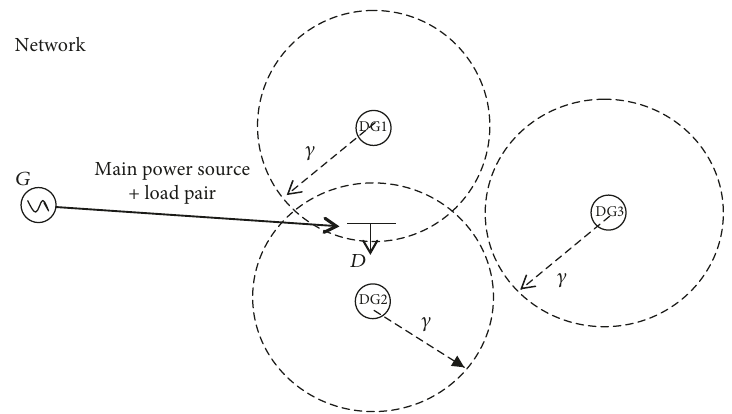
Figure 1: Sketch for effective supply area of